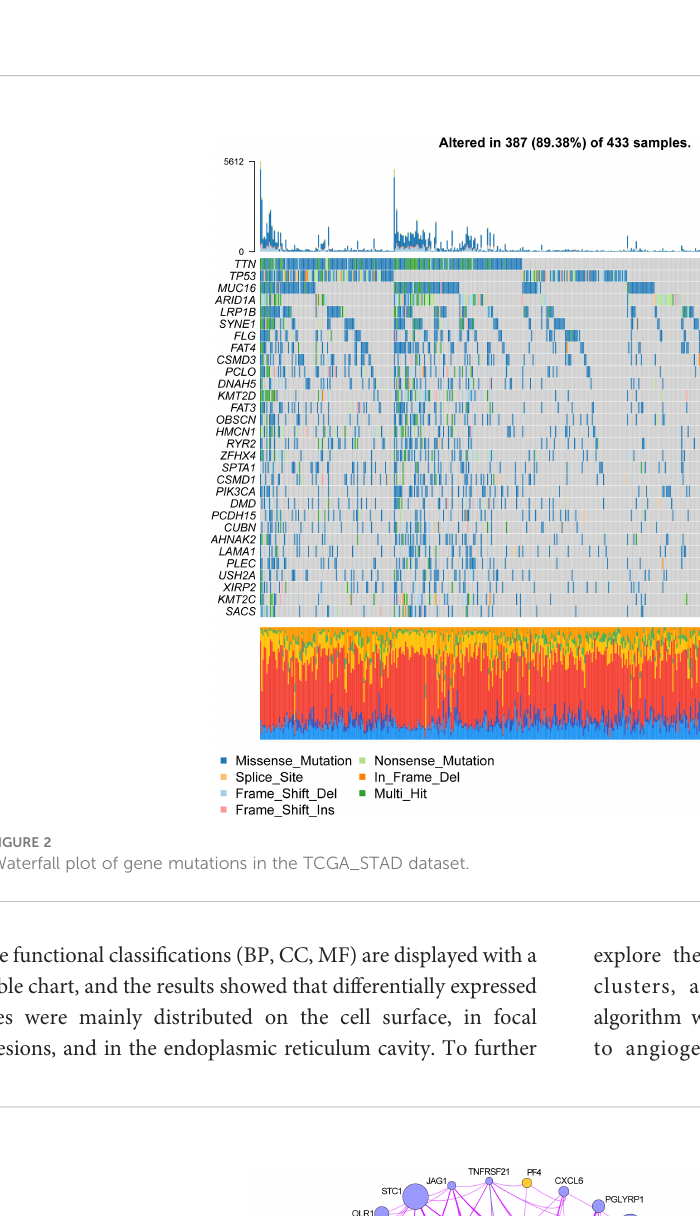
three functional classi fi cations (BP, CC, MF) are displayed with a bubble chart, and the results showed that differentially expressed genes were mainly distributed on the cell surface, in focal adhesions, and in the endoplasmic reticulum cavity. To further